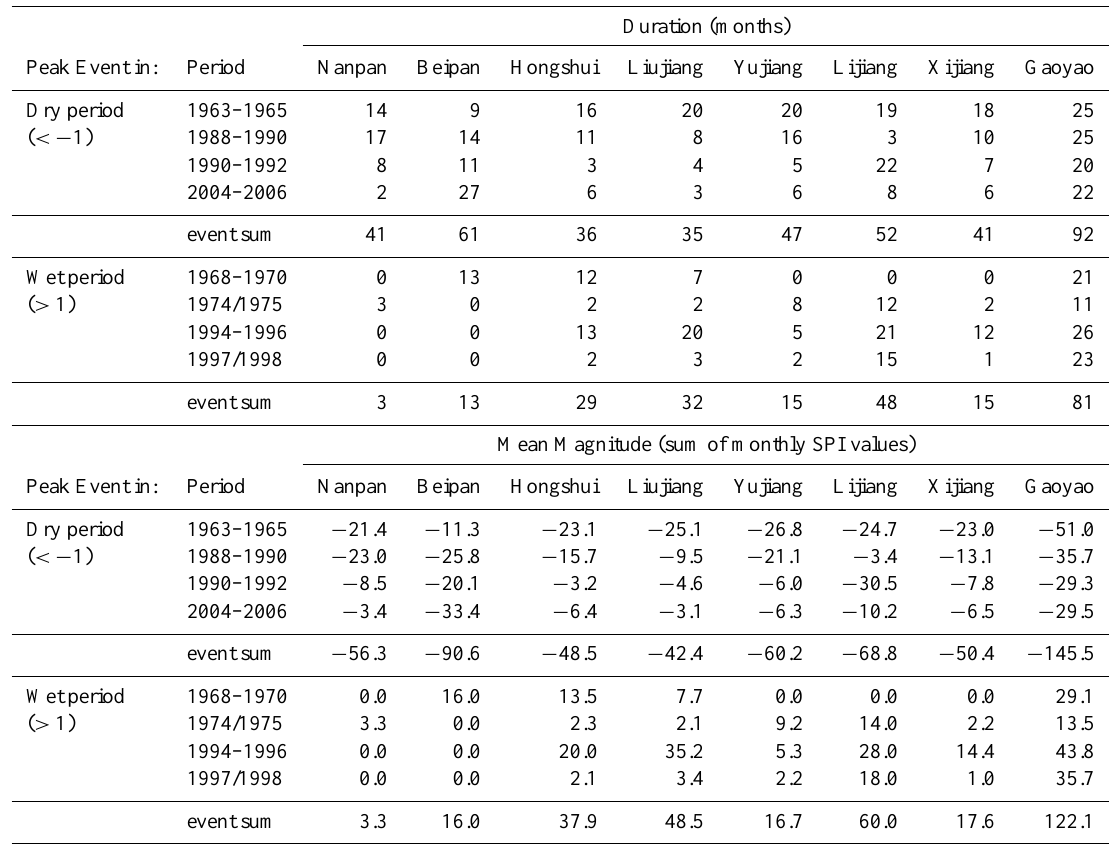
Table 1. Duration and magnitude of peak events in dry (SPI < − 1) and wet (SPI > 1) periods in the six sub-basins of the Xijiang River basin, the entire basin (Xijiang), and at Gaoyao hydrological station (SDI < − 1, SDI > 1),